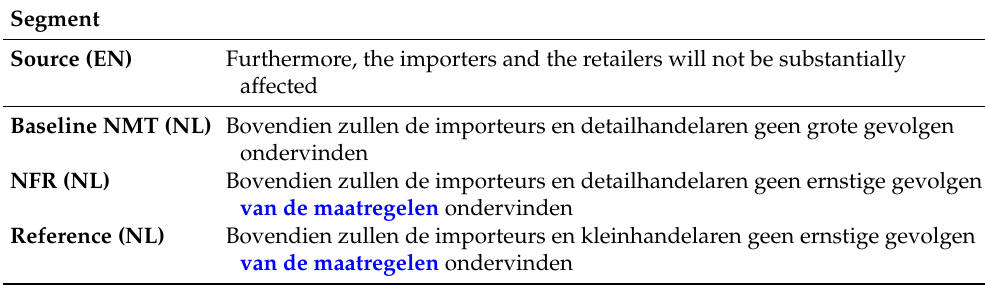
Table 16. Example of an addition found both in the NFR output and the reference